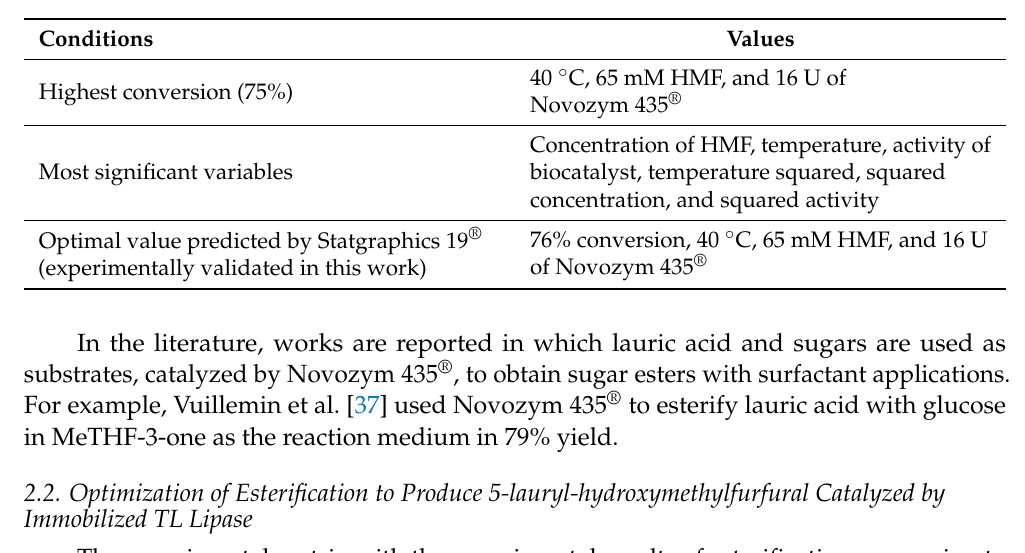
Table 2. Summary of the variables and conditions that maximize the conversion of the reaction